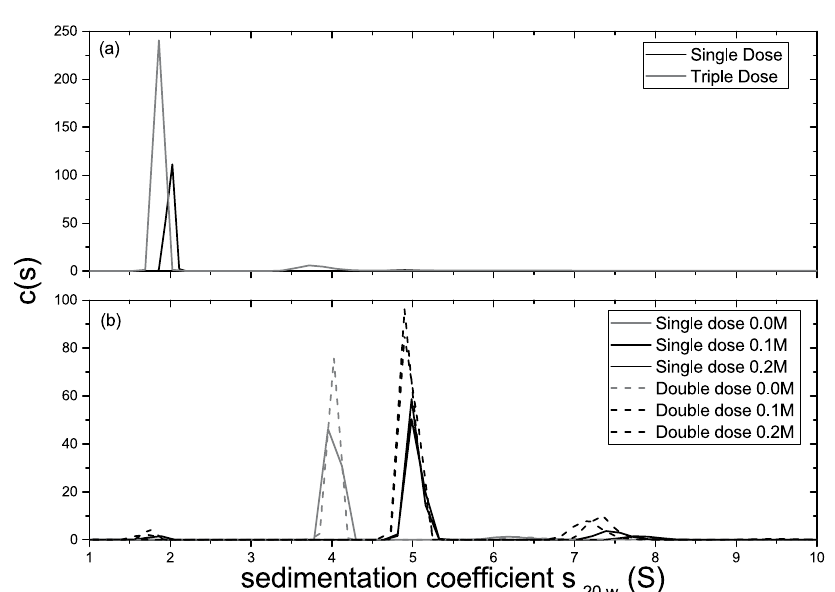
Figure 2. The sedimentation coefficient distribution c( s ) plotted against sedimentation coefficient s (corrected for solvent conditions) for insulin samples obtained through AUC-SV. ( a ) Insulin glargine; ( b ) Insulin degludec at 0.0, 0.1 and 0.2 M ionic